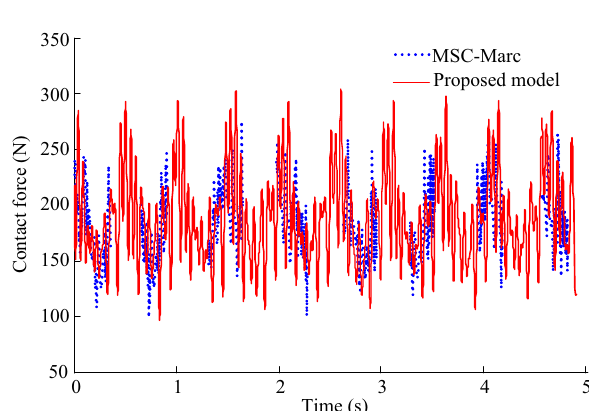
Fig. 6 Comparison in computation results of contact force between MSC Marc and flexible cable